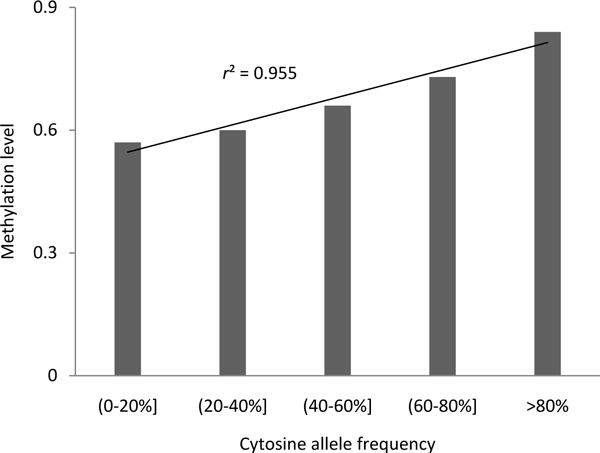
The correlation between methylation level and cytosine allele frequency. The X-axis includes five classes of CpG sites defined on the basis of their cytosine allele frequency. The Y-axis is the methylation level that was computed as the number of methylated reads over the total number of reads mapped to each cytosine base. The correlation coefficient (r2) is shown on the plot.